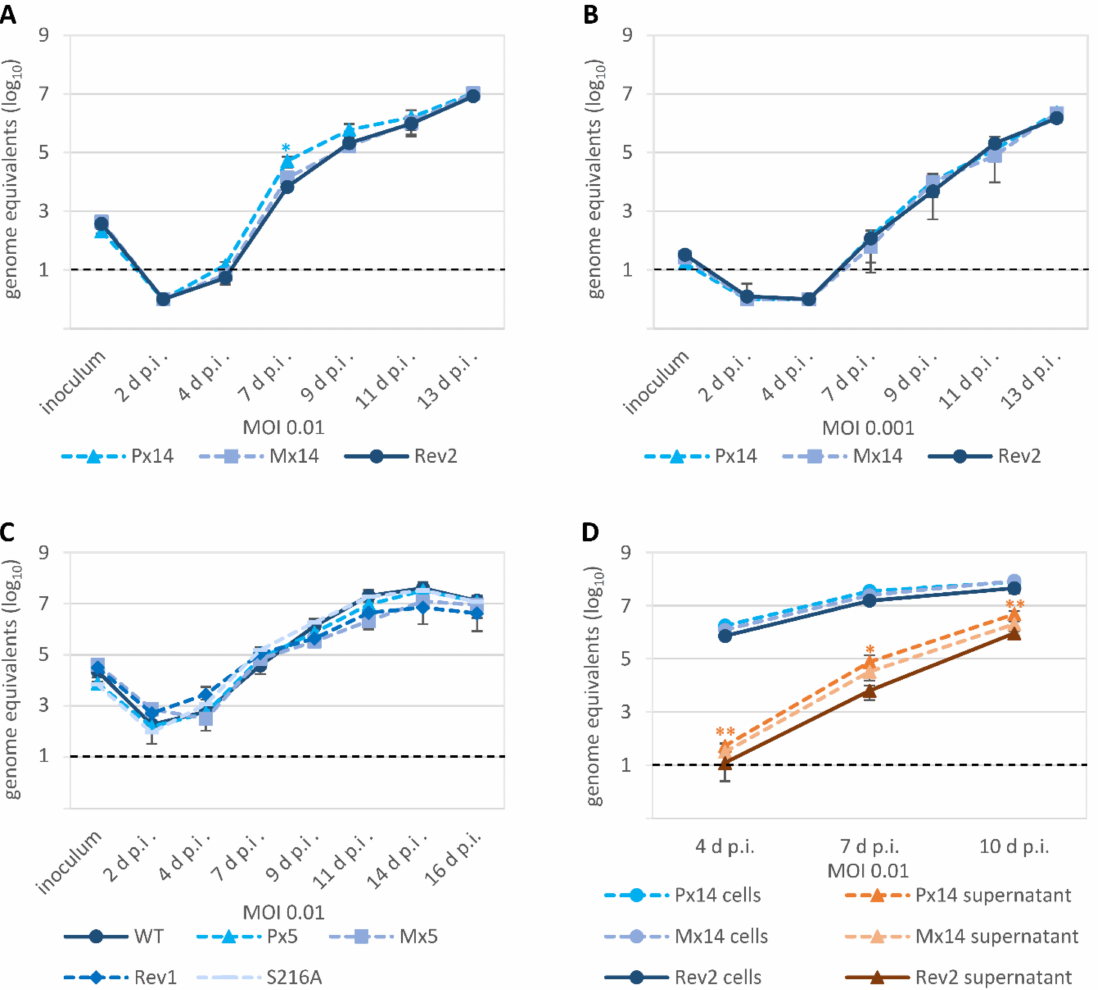
Figure 6. HCMV replication kinetics of the pUL50 phosphosite mutants. HFFs were infected with parental HCMV AD169 (WT) or recombinant HCMV phosphosite mutants P × 14, M × 14, Rev2, P × 5, M × 5, Rev1 or S216A at a MOI of 0.01 or 0.001 as indicated. Viral supernatants ( A – D ) or cells ( D ) were harvested at the indicated time points and viral genome equivalents were determined by IE1-specific qPCR. Each infection was performed at least in triplicates; mean values and standard deviations are shown. The significance is calculated relating to Rev2 or WT (solid lines). The standard containing 10 HCMV DNA copies reached the cycle threshold at cycle 38 and was therefore defined as the limit of detection for qPCR, as shown by the black dashed line. *, p ≤ 0.05; **, p ≤